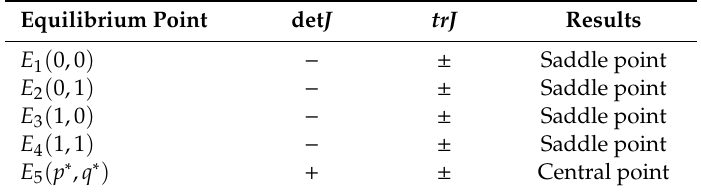
Table 4. The evolutionary stability of local equilibrium points in Case